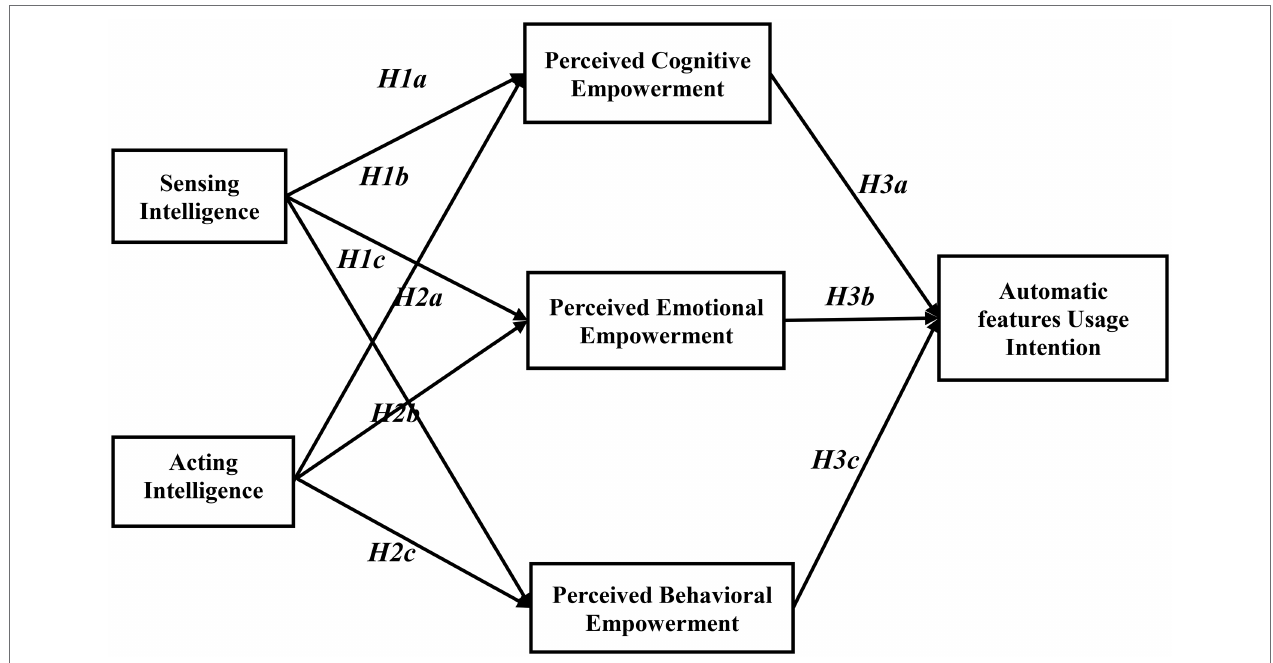
FIGURE 1 | Research model and